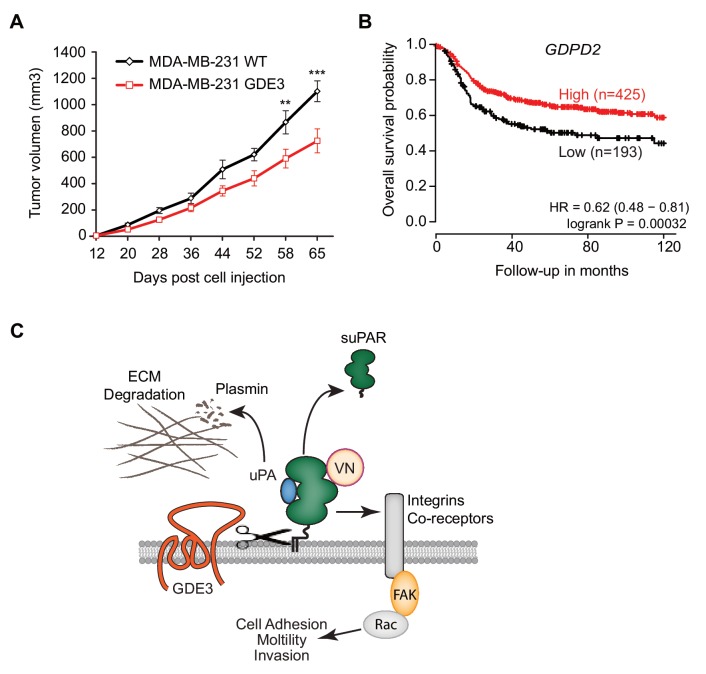
GDE3 overexpression in breast cancer cells slows tumor growth in mice, correlating with higher survival probability in patients.(A) Female nude mice (n = 16) were injected with either wild-type or GDE3-overexpressing MDA-MB-231 cells into the mammary fat pad, as described under Materials and methods. Tumor volume was measured every three days after injection for 9 weeks until the tumor had grown to the appropriated size (data represent the mean ±SEM; **p<0.01; ***p<0.001, t-test corrected for multiple comparison). (B) High GDPD2 expression significantly correlates with higher survival rate in triple-negative (basal-like) subtype breast cancer patients (N = 618). HR, hazard ratio with 95% confidence interval indicated. Analysis based on microarray data (www.kmplot.com). (C) Schematic model. GDE3 functions as a GPI-PLC that cleaves and sheds uPAR, leading to loss of uPAR function. VN, vitronectin, FAK, focal adhesion kinase, suPAR, soluble uPAR.